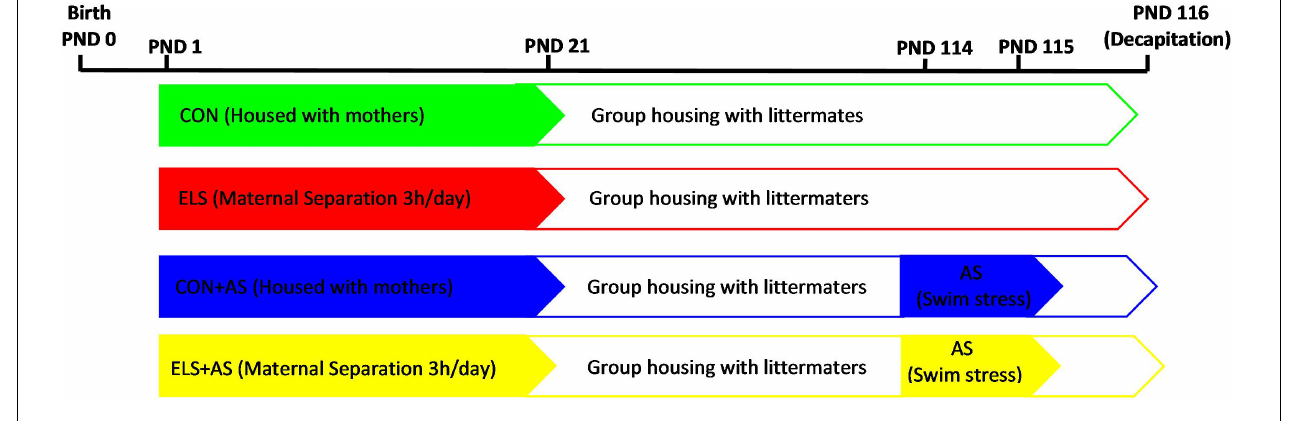
FIGURE 1 | Experimental